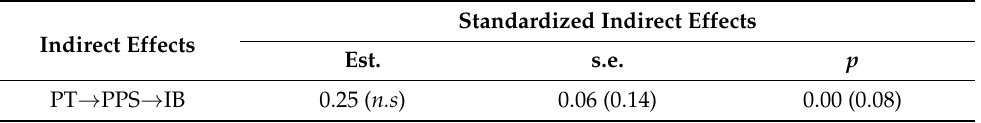
Table 4. Indirect effects of the estimated multi ‐ group SEM.